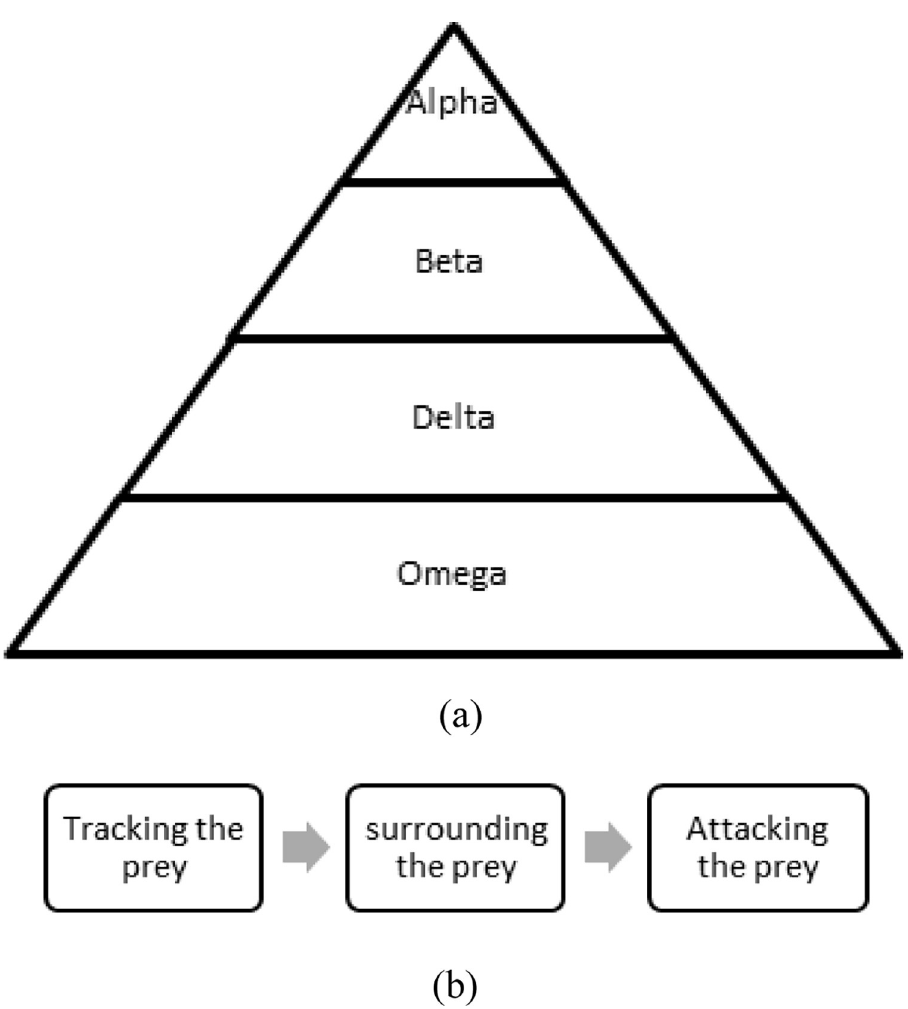
Fig 1. GWO (a) social hierarchy; (b) Process flow.